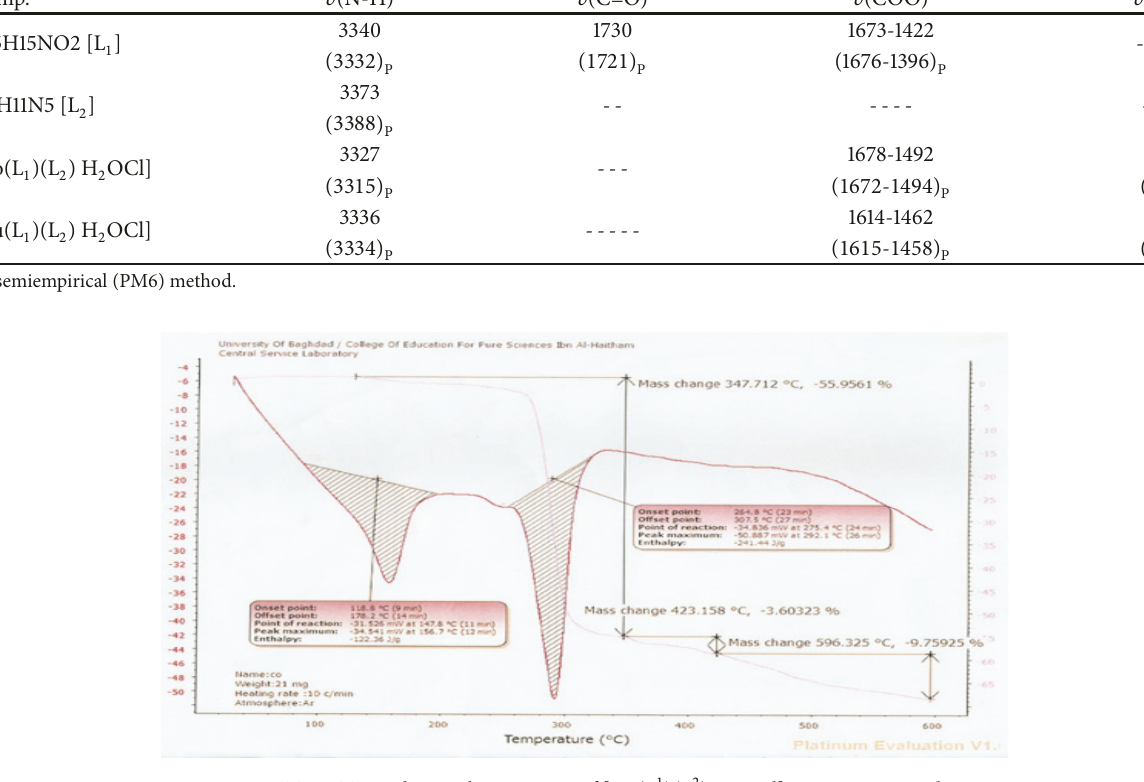
Figure 5: TG/DTG and DSC thermogram of [Co(L 1 )(L 2 ) H 2 OCl] in argon atmosphere.